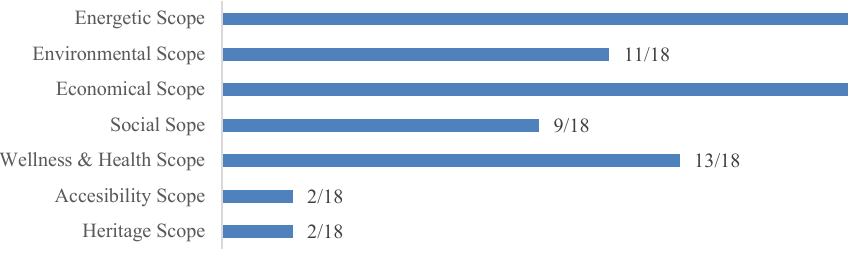
Fig. 1. Percentage of projects assessing each ‘Assessment